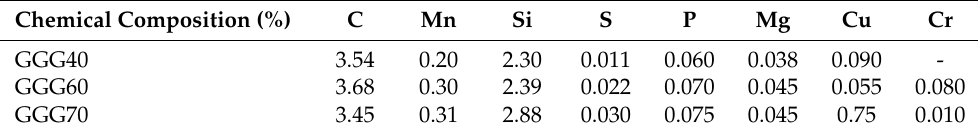
Table 1. Chemical composition of GGG40, 60 and 70.